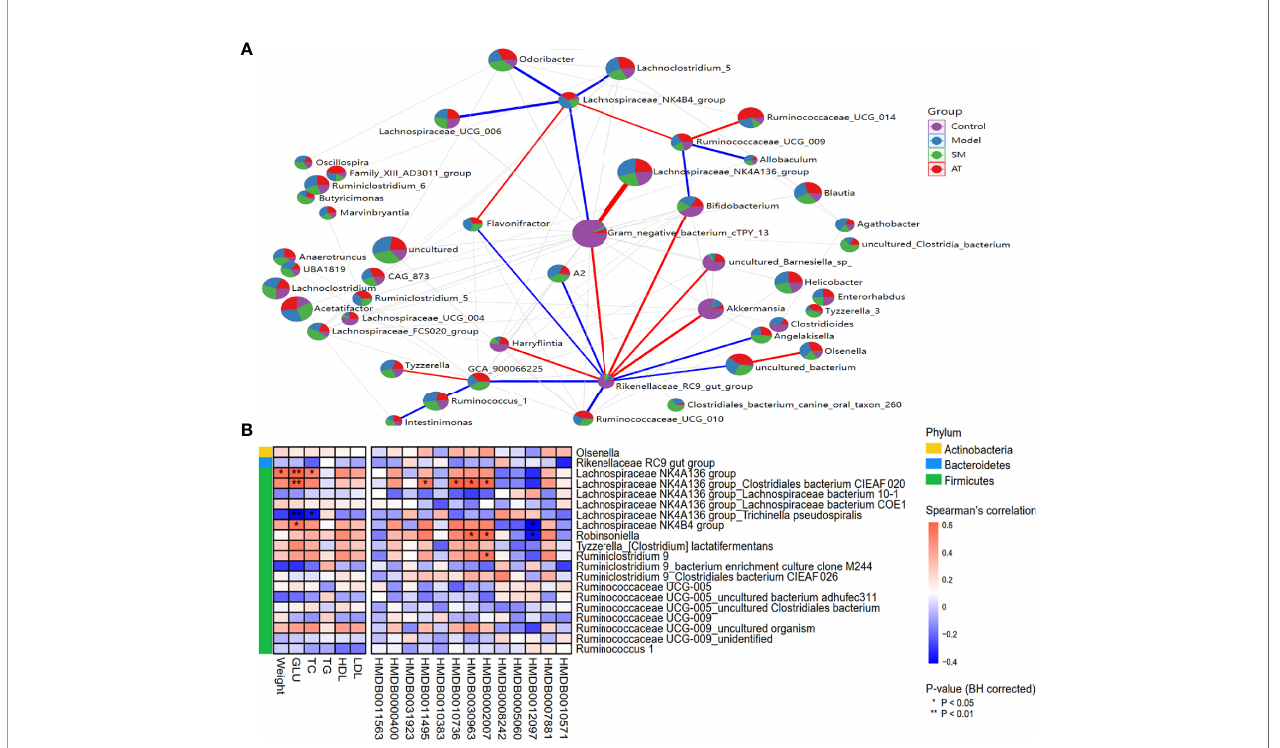
FIGURE 5 | (A) Network between abundant sequences at the genus level built from SparCC correlation coef fi cients. (B) Heatmap of Spearman correlation among hyperlipidemia-related indexes, identi fi ed metabolites, and intestinal microbiota at genus level. For P-values of correlations, * indicated statistically signi fi cant correlation (* P < 0.05 ; ** P